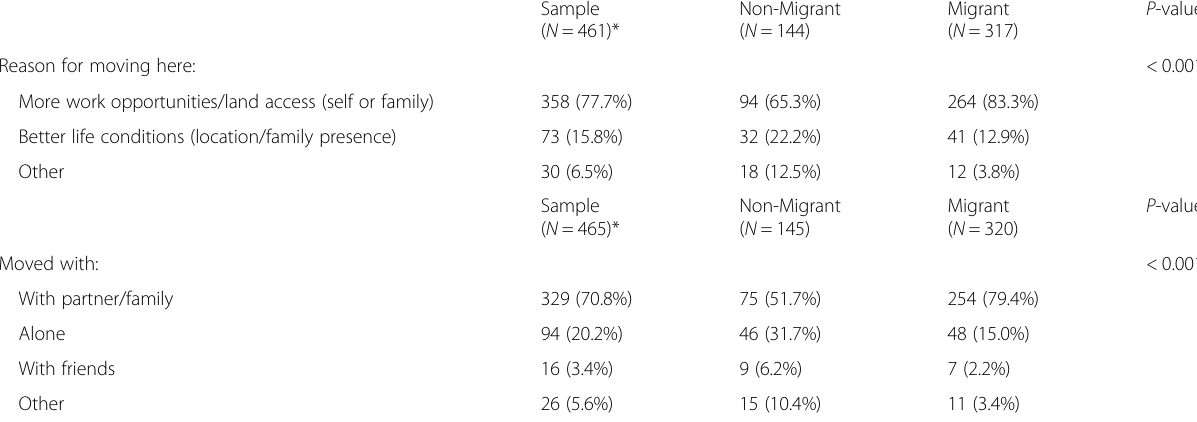
Table 8 Social capital: Reasons for migration